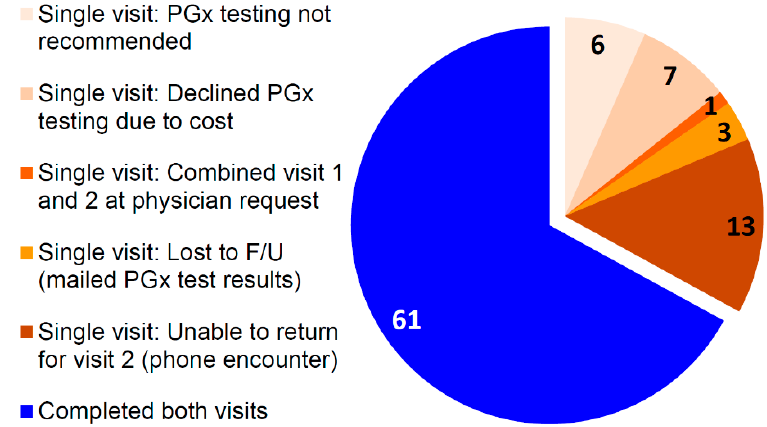
Figure 4. Number of referrals to the pharmacogenetics consult clinic by referral type (i.e., therapeutic area(s) of medication(s) identified by referring internal medicine physician as warranting drug therapy optimization with pharmacogenetics [n = 91], based on suggested referral criteria). Cardio: Cardiology; Gastro: Gastroenterology; Psych: Psychiatry.